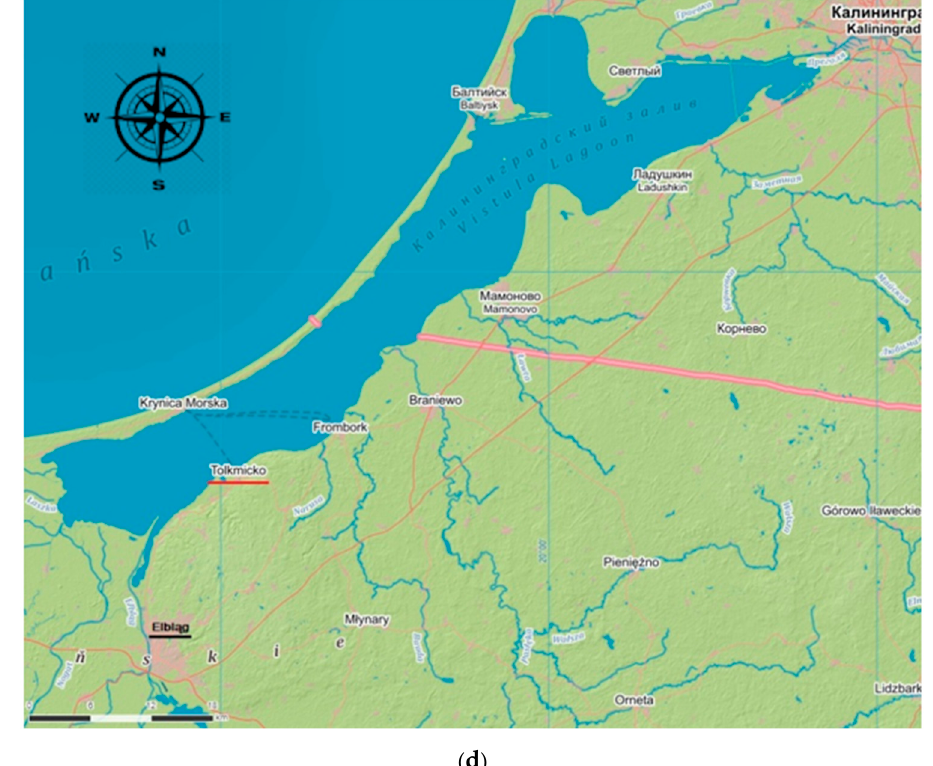
Figure 1. ( a ) Location of coastal lagoons on the southern Baltic Sea coast; and maps of ( b ) Szczecin Lagoon; ( c ) Puck Lagoon; and ( d ) Vistula Lagoon. In figure ( a ) the dotted line marks the border of the Puck Lagoon. In figures ( b – d ) the black line underline weather stations and the red lines show ice monitoring stations, the pink line marks the state border. Source of maps ( b – d ): https://en.mapy.cz/, accessed on 14 July 2021, maps were slightly modified by authors.